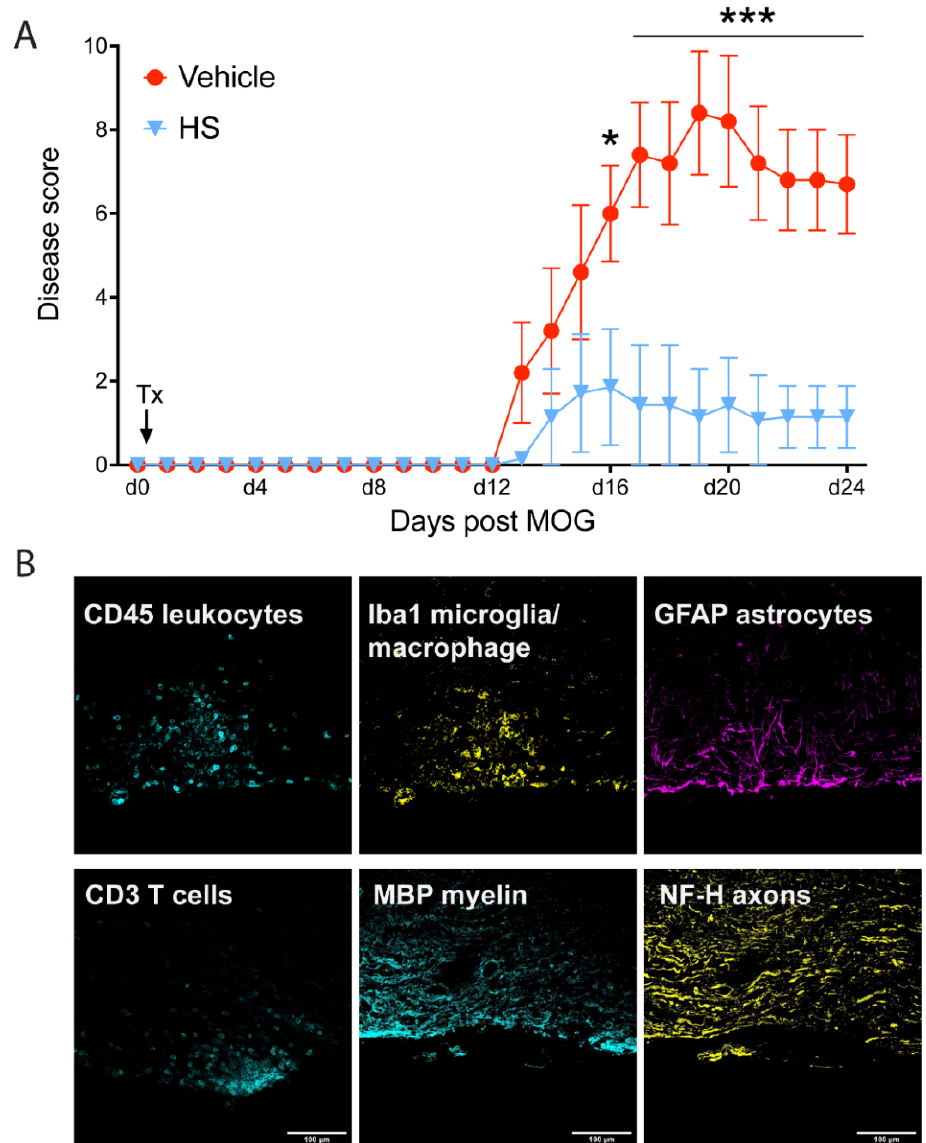
Figure 6. Oral HS treatment of mice immunized for EAE attenuates clinical disability. ( A ) While all 7 mice treated with vehicle develop severe EAE, this is significantly attenuated when mice are treated with HS (n of 5 mice). * p < 0.05, *** p < 0.001 (two-way ANOVA with repeated measures). Treatment initiation of the daily oral gavage is indicated by ‘Tx’. Please see Supplementary Video S2 for the disability in mice representative of both groups. ( B ) Longitudinal thoracic sections of the spinal cord are stained for the various markers, and here, high-magnification images are displayed of a lesion (hypercellularity) of leukocytes (CD45+), some of which are CD3+ T cells and Iba1+ macrophages, along with microglia/macrophages (Iba1+), and reactive astrocytes (GFAP+); the respective colors are defined by the words in each panel. The edge of the tissue is at the bottom part of each panel. Disruption of MBP+ (myelin basic protein+) myelin and NFH+ (neurofilament heavy chain) axons can be seen in that lesion. Scale bar is 100 μ m.